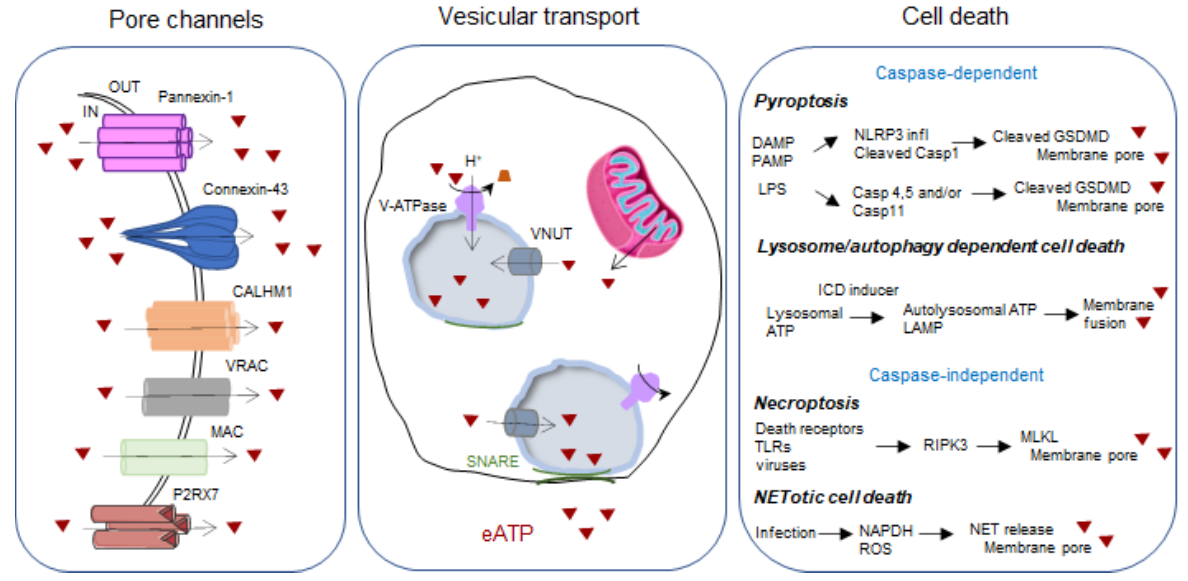
Figure 1. Schematic illustration of the mechanisms involved in the release of eATP.